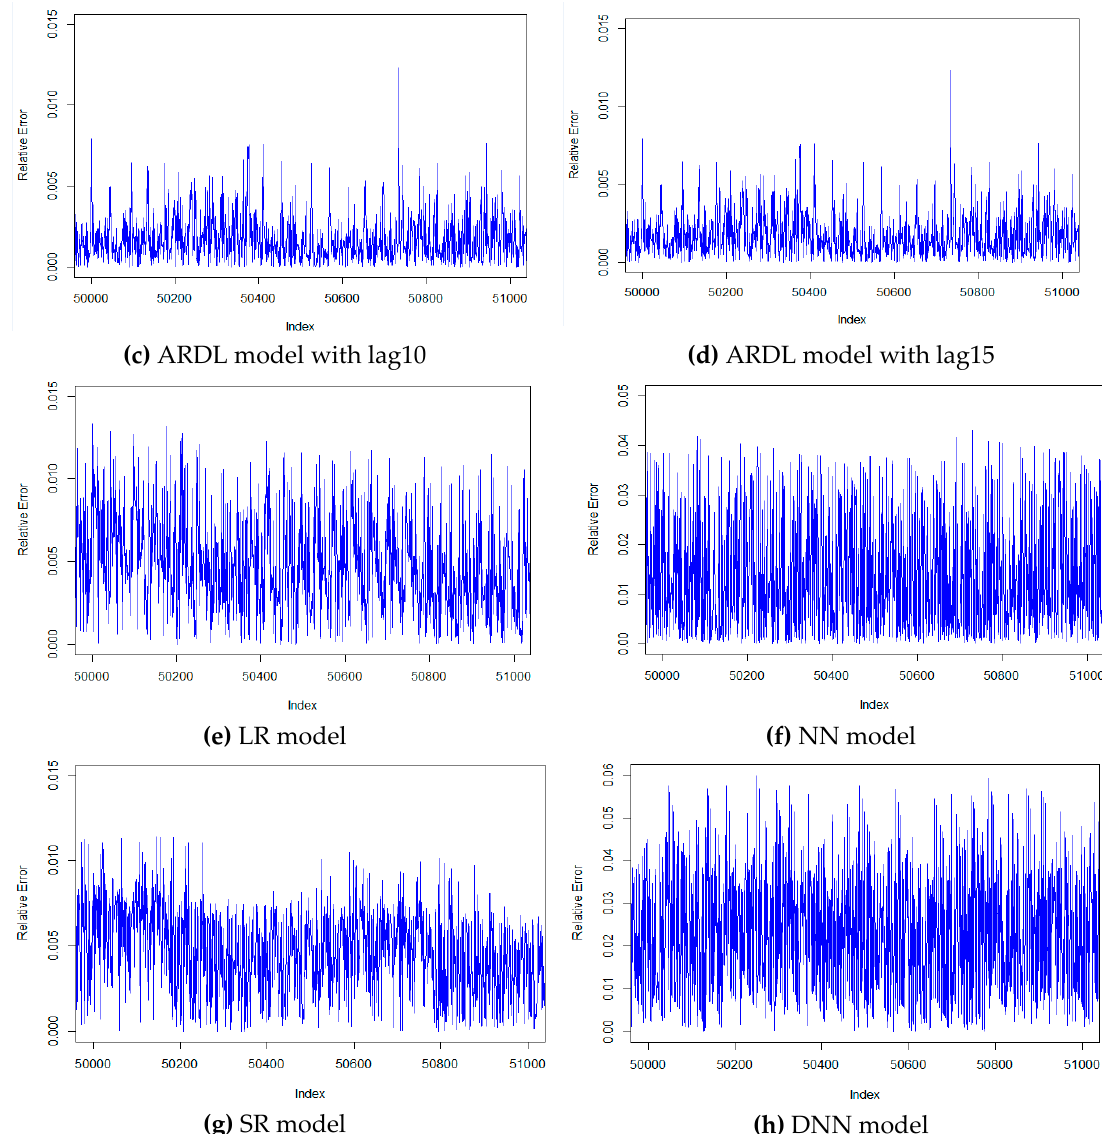
Figure 4. Relative error of all models for predicting the GTCOAT temperature. Figure 4 contains eight graphs, which were listed as follows: ( a ) ARDL model with lag 1, ( b ) ARDL model with lag 5, ( c ) ARDL model with lag 10, ( d ) ARDL model with lag 15, ( e ) LR model, ( f ) NN model, ( g ) SR model, ( h ) DNN model.